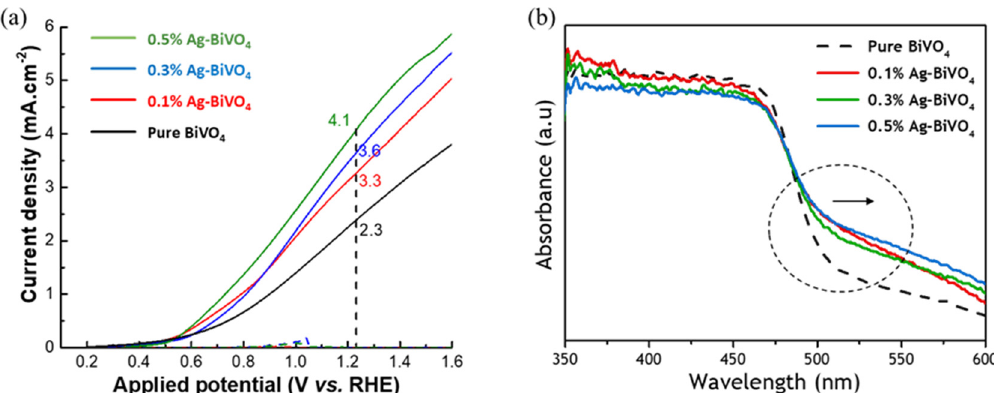
Figure 2. ( a ) Photocurrent densities of pure BiVO 4 and Ag–BiVO 4 photoanodes in the dark and un- der solar illumination. ( b ) UV–visible spectra of pure BiVO 4 and Ag–BiVO 4